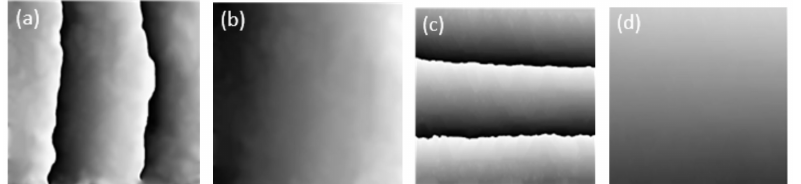
Figure 9. The phase maps corresponding to the object with a hyperbolic paraboloid surface, including ( a ) the filtered phase map, ( b ) the unwrapped phase map in the X direction, ( c ) the filtered phase map, and ( d ) the unwrapped phase maps in the Y direction.